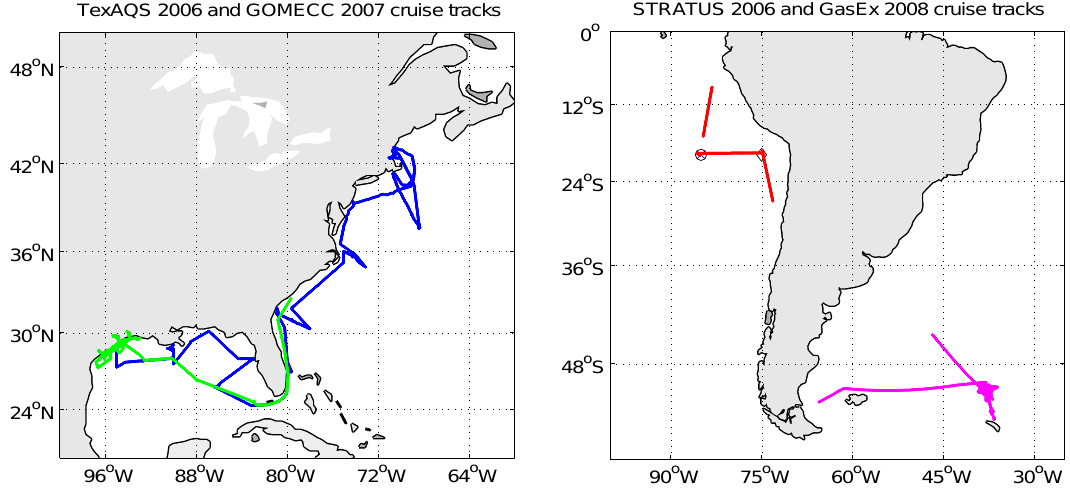
Fig. 3. Cruise tracks of the NOAA ship Ronald H. Brown during TexAQS-2006, STRATUS-2006, GOMECC-2007, and GasEx-2008. The TexAQS cruise (green) took place mainly off the coast of Texas and along the Houston and Galveston Ship channels between 27 July and 12 September 2006. The GOMECC cruise (blue) occurred between 10 July and 4 August 2007 along the US coast of the Gulf of Mexico and the US Atlantic coast. The STRATUS cruise (red) started in Panama on 9 October and ended in Chile on 27 October 2006. The GasEx cruise started in Punta Arenas, Chile, on 29 February and ended in Montevideo, Uruguay, on 11 April 2008 (magenta).